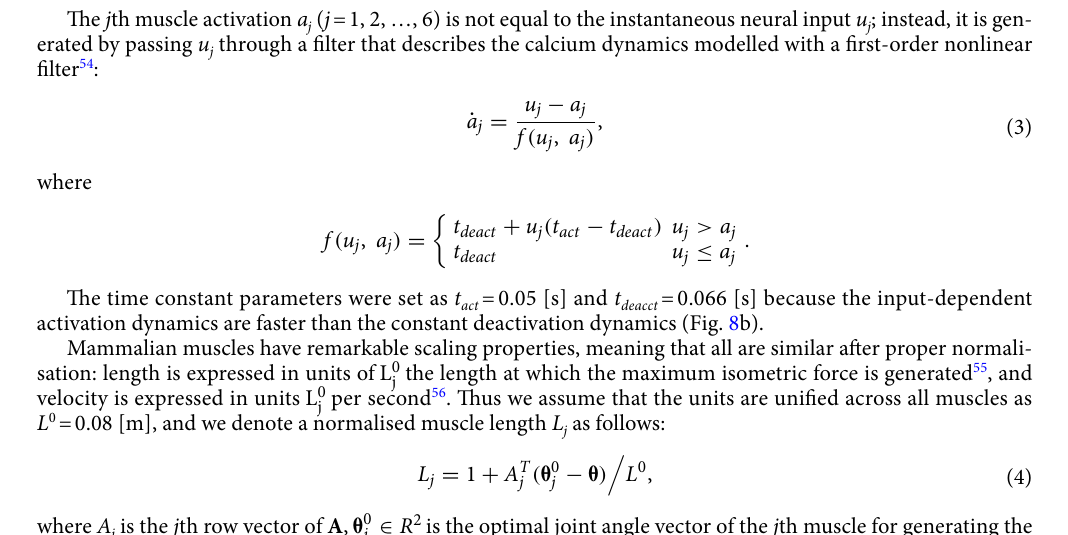
Figure 8. Simulation model. ( a ) Allocation of muscles in the two-link, six-muscle arm model. The SF models the pectoralis major, coracobrachialis, and deltoid anterior muscles. The SX models the posterior and middle deltoid muscles. The BF models the long and short biceps muscles. The BX models the long triceps muscle. The elbow flexor (EF) models the brachialis, brachioradialis, and extensor carpi radialis longus muscles. The elbow extensor (EX) models the lateral and medial triceps muscles. ( b ) Muscle activation dynamics. ( c ) Length– velocity–tension curve of the muscle